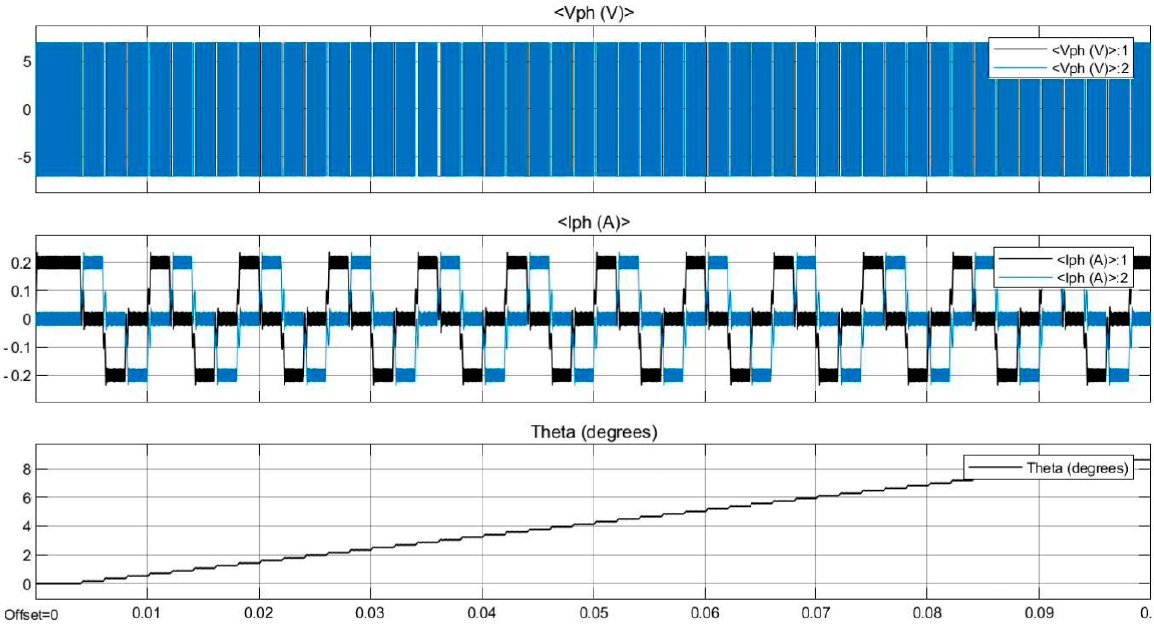
Figure 10. Simulation results.